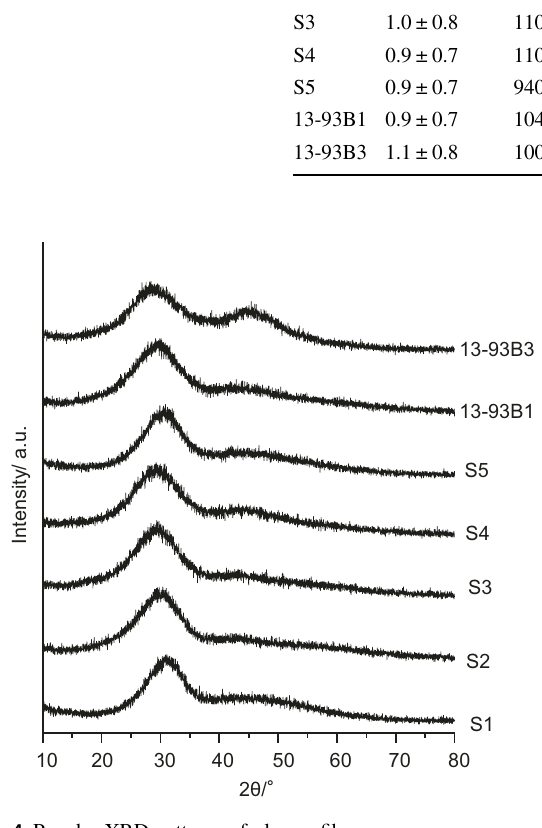
Fig. 4 Powder XRD patterns of glasses fi bers